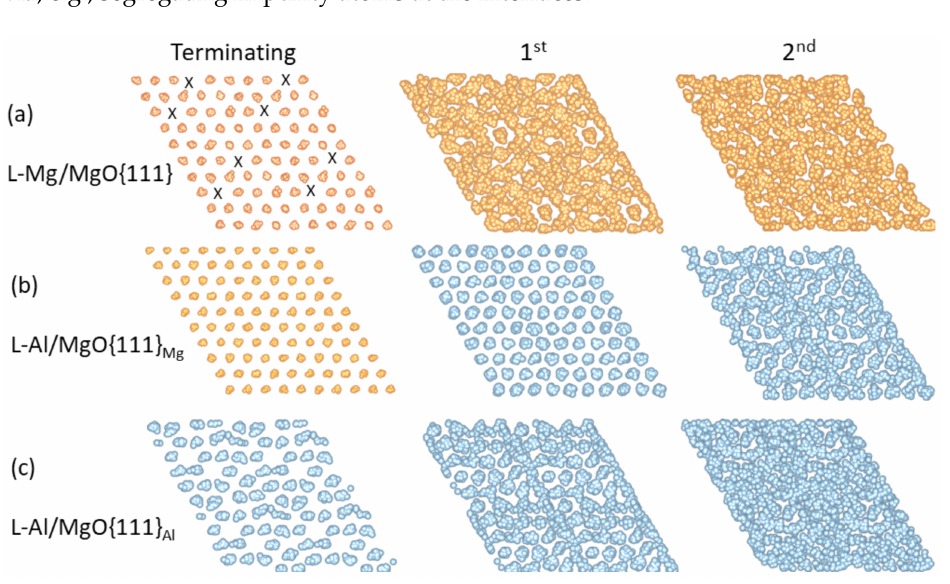
Figure 9. There are atomic vacancies (marked by X) at the terminating layer at the Mg( l )/MgO{1 1 1} and the termination metal atoms display localized nature. Time averaged atomic arrangements in the terminating, 1st and 2nd Al layers at the ( a ) the equilibrated Mg( l )/MgO{1 1 1}, ( b ) Al( l )/MgO{1 1 1} Mg and ( c ) Mg( l )/MgO{1 1 1} Al interfaces [49,50,63]. The meaning of the spheres is the same as in Figure 7.